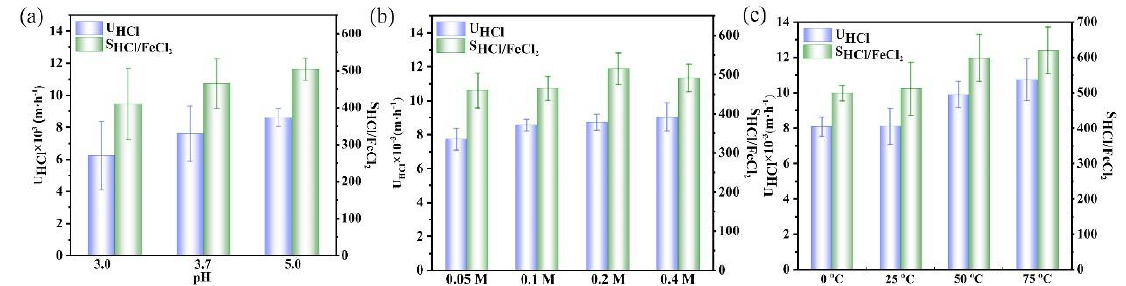
indicated that there was a strong electrostatic adsorption between the carboxyl group on U-C(60) and Fe 2+ .